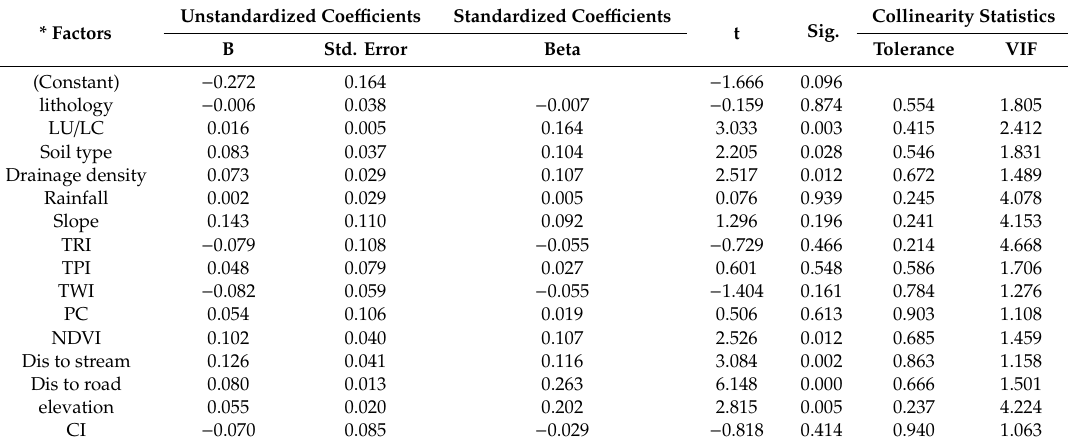
Table 2. Multi-collinearity analysis among gully erosion conditioning